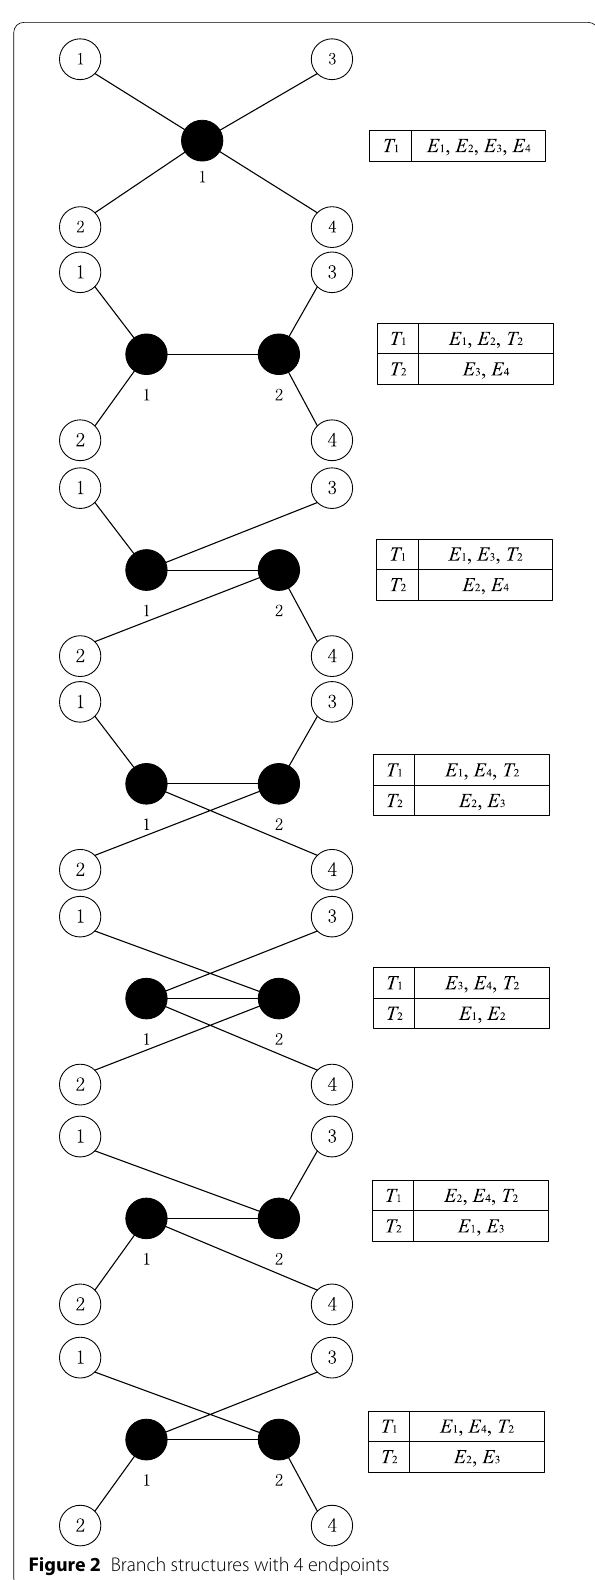
Figure 2 Branch structures with 4